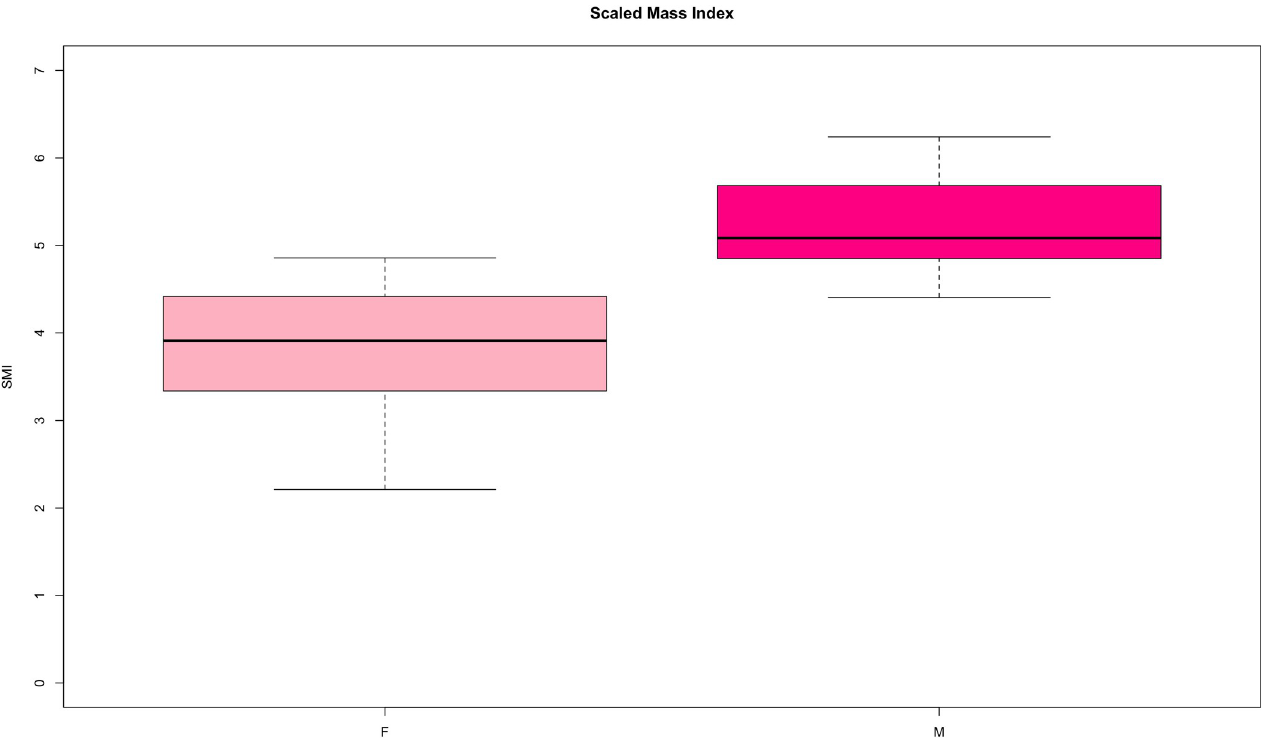
Fig 3. Scaled mass index comparison. Boxplots showing the distribution of SMI values in males and females of analyzed pink iguanas.